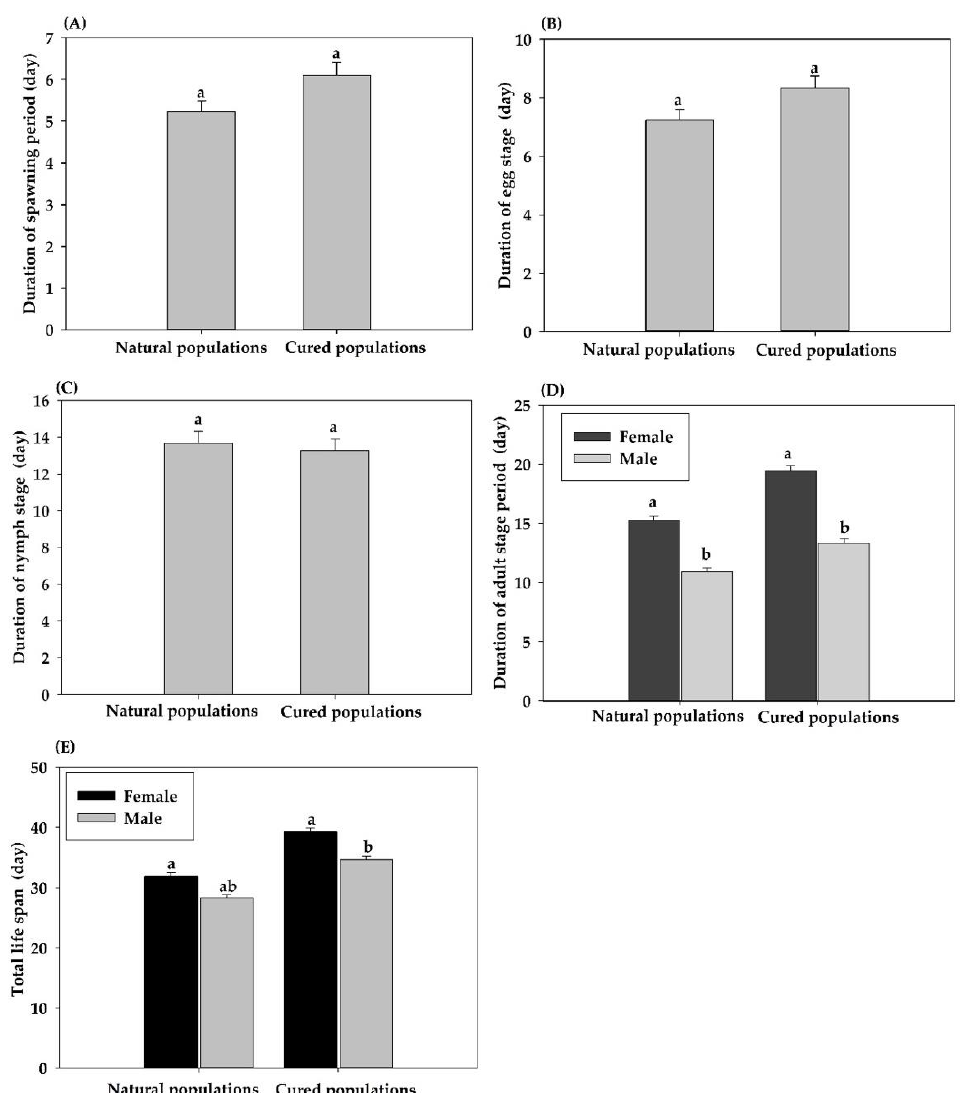
Figure 6. Influence of symbiotic bacteria Wolbachia on the developmental duration of different stages of the tea green leafhopper: ( A ) spawning period; ( B ) egg stage; ( C ) nymph stage; ( D ) adult stage period; ( E ) total life span. Different letters indicate significant differences at p ≤ 0.05.